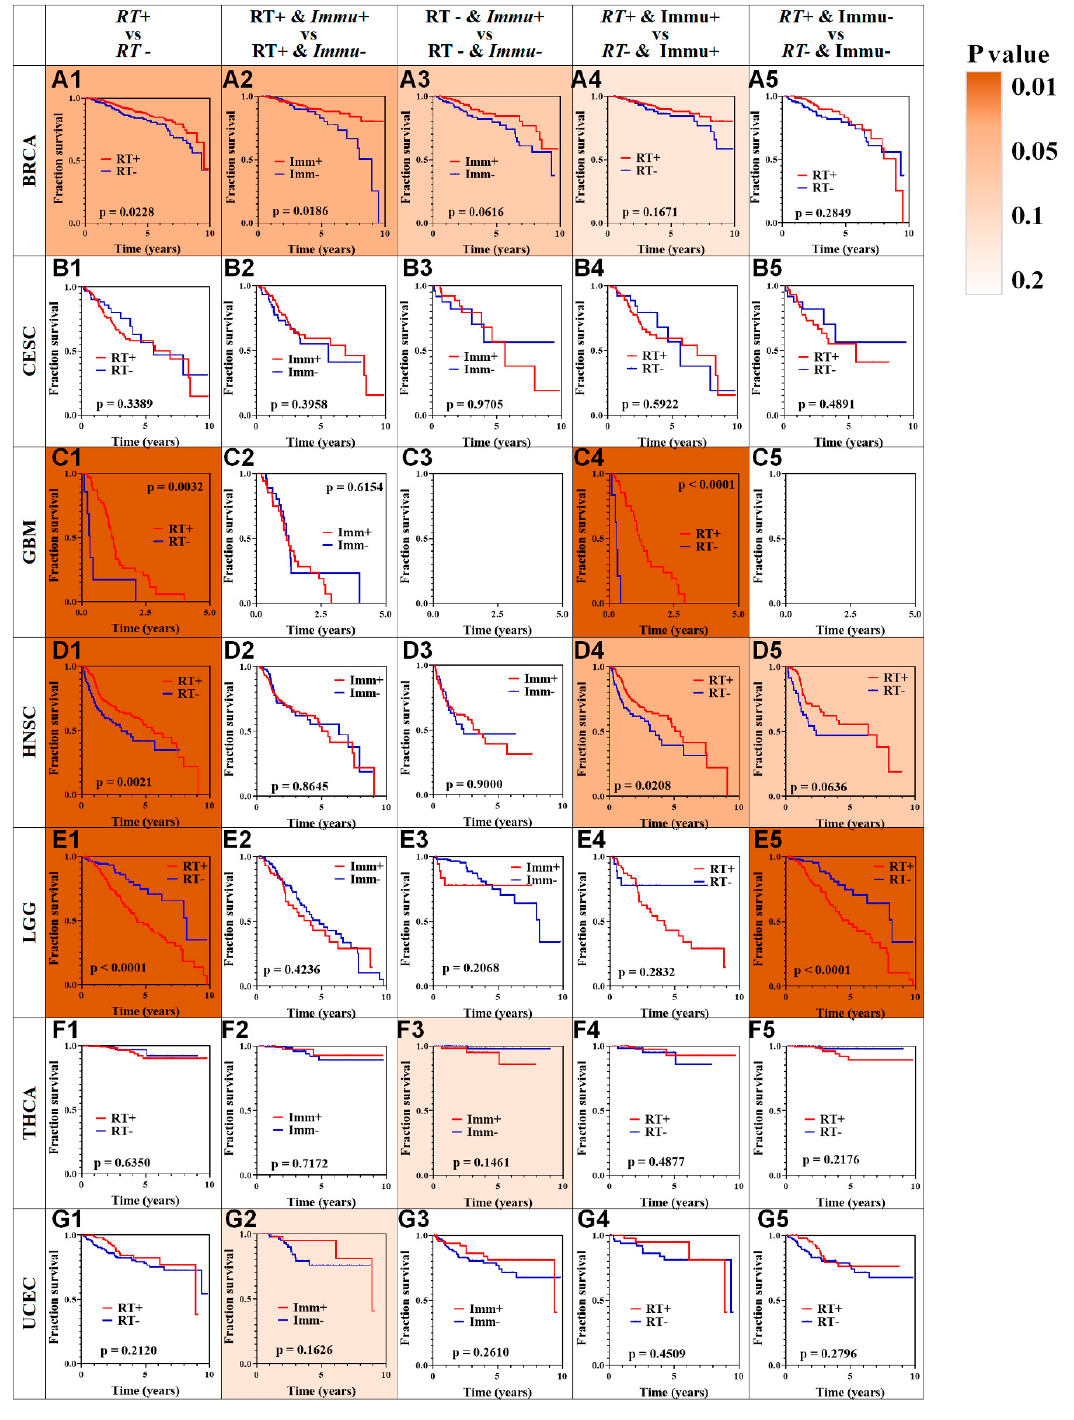
Figure 2. Survival analysis across seven cancer types. Each row represents a type of cancer and each column represents a different grouping. For each type of cancer ( A - G ), we performed five different survival analysis (numbers 1–5, refer to Figure 1D). A Kaplan–Meier Plotter was used to test for survival prediction capacity. A combination of letters ( A - G ) and numbers (1–5) were used to number all the results. Correspondingly, the patients with an immune score greater than zero were defined as positive (+), and those with a score below zero were defined as negative (-). Additionally, patients with or without RT treatment were defined as positive (+) or negative (-), respectively. A total of seven types of cancer were analyzed: BRCA( A1 - A5 ), CESC( B1 - B5 ), GBM( C1 - C5 ), HNSC( D1 - D5 ), LGG( E1